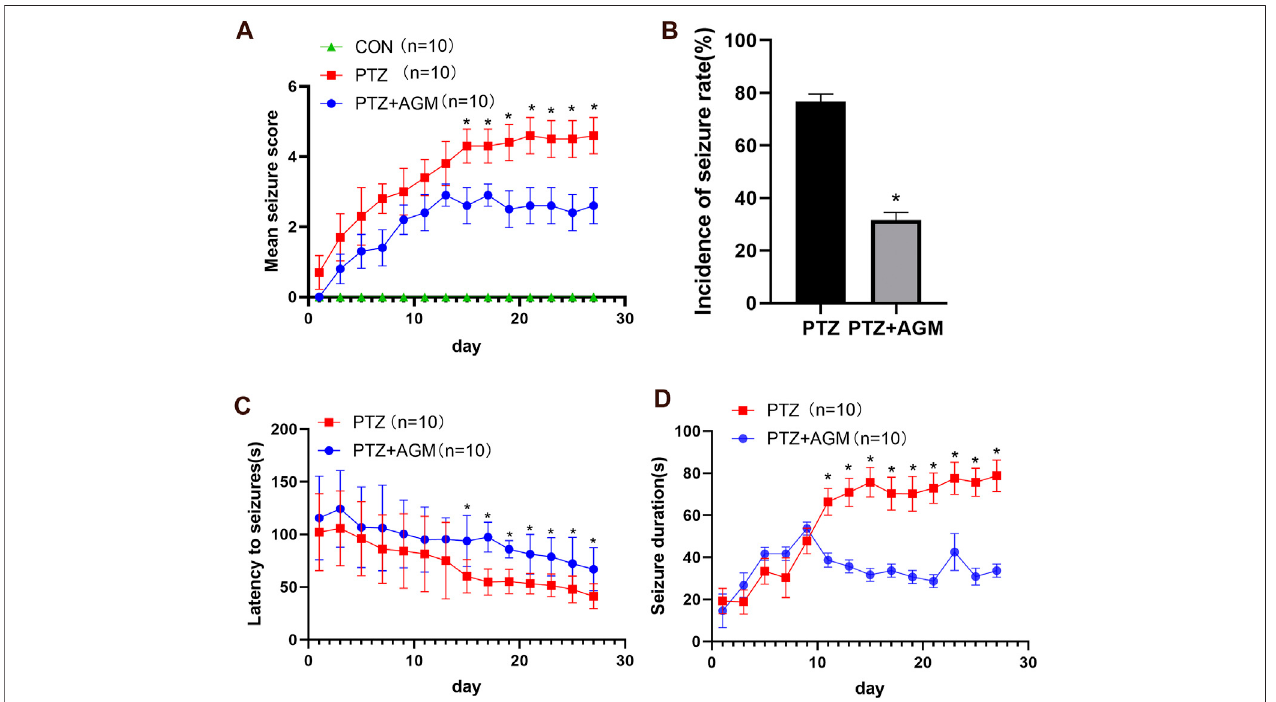
FIGURE 1 | Effects of AGM on PTZ kindling-induced seizure. (A) Statistical result showing AGM decreased seizure score (two-way ANOVA with repeated measures followed by Bonferroni or Dunnett ’ s T3 post hoc test). (B) Statistical results showing AGM decreased the incidence of seizure rate (chi-square test). (C) StatisticalresultsshowingAGMincreasedthelatencytoseizures(two-wayANOVAwithrepeatedmeasures). (D) StatisticalresultsshowingAGMdecreasedtheseizure duration(two-wayANOVAwithrepeatedmeasures).Errorbarsrepresentmean ± standarddeviation(n (cid:1) 10pergroup).# p ＜ 0.05vsthecontrolandPTZgroup,* p ＜ 0.05 vs the PTZ group and PTZ + AGM